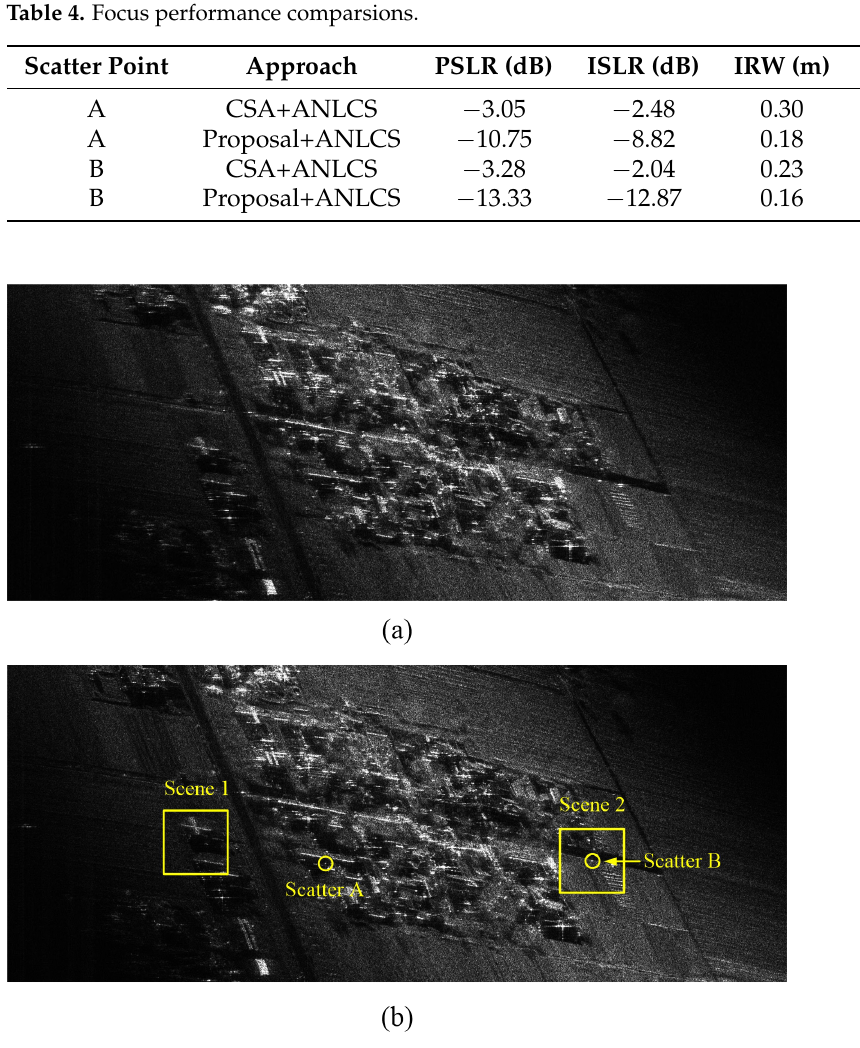
Figure 7. Scene imaging comparisons. ( a ) Processed by CSA+ANLCS; ( b ) Processed by pro-